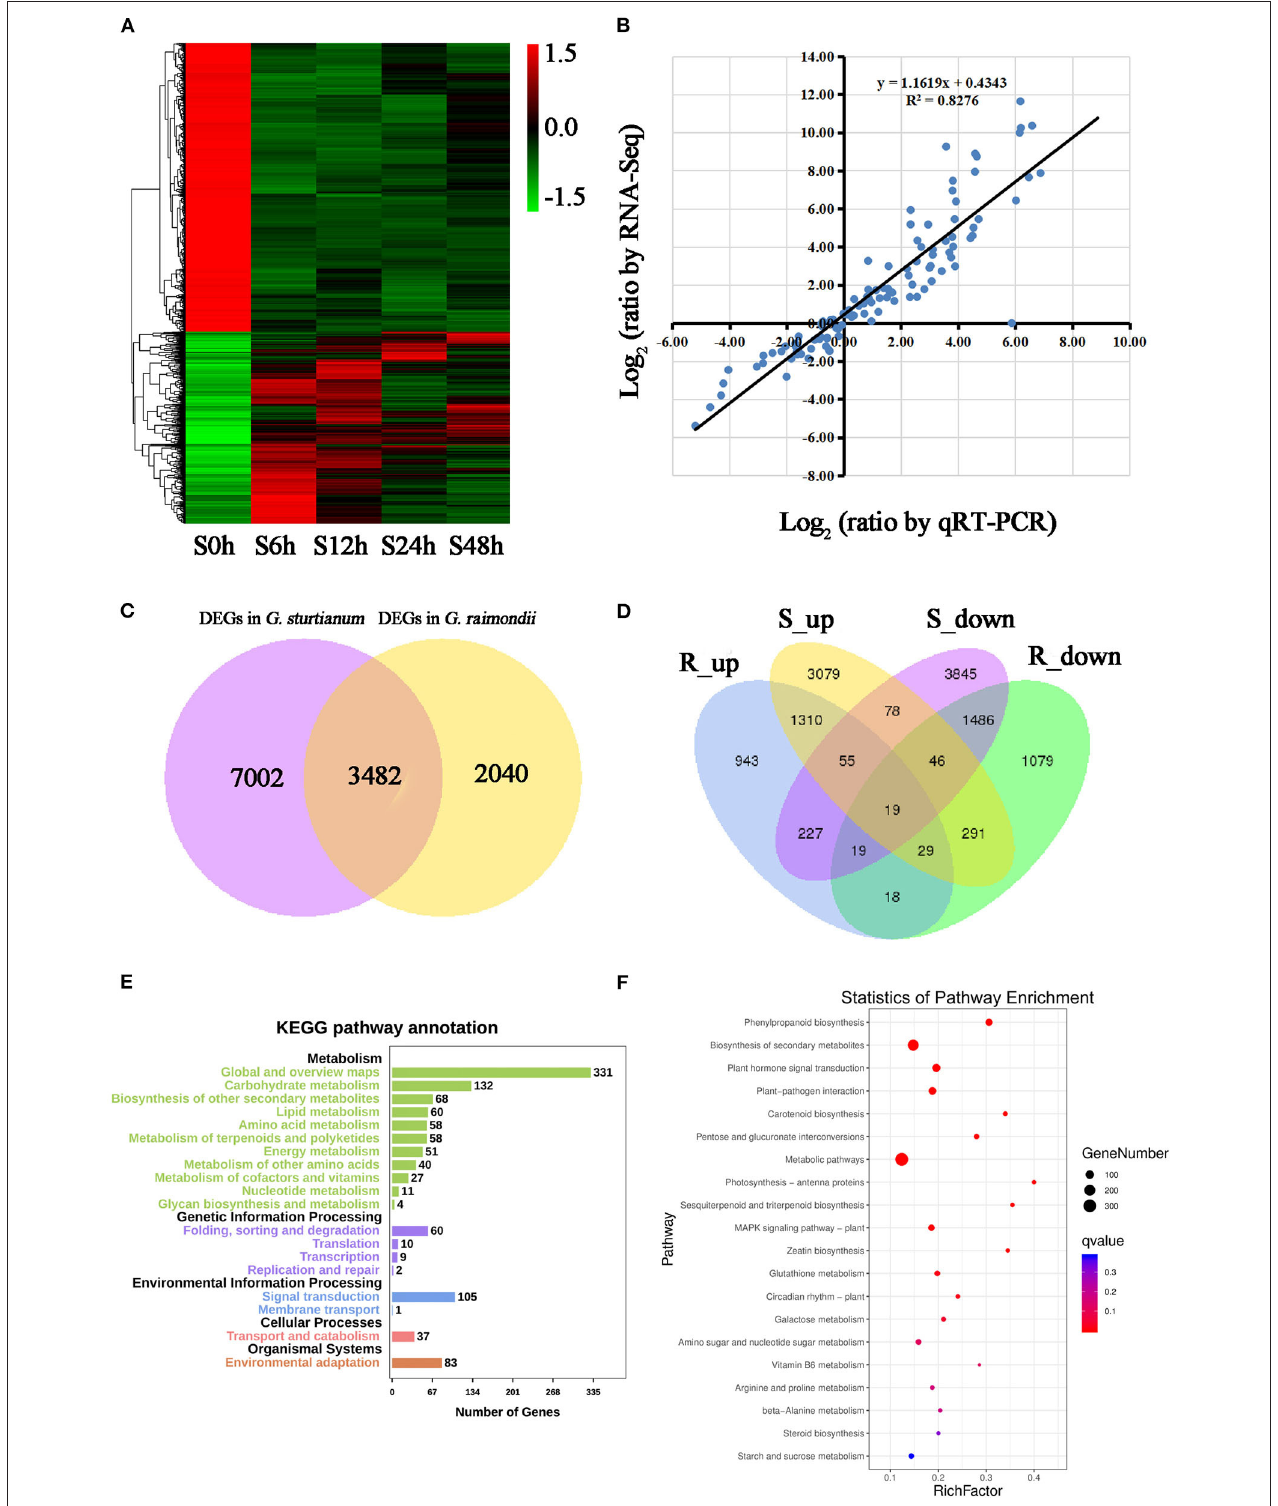
FIGURE 3 | Identification and functional analysis of differently expressed genes during different stages under salt stress in G. raimondii and G. sturtianum ; (A) Heatmap of differential expression during diverse phases under salt stress in G. sturtianum ; (B) Correlation analysis of gene expression profiles between